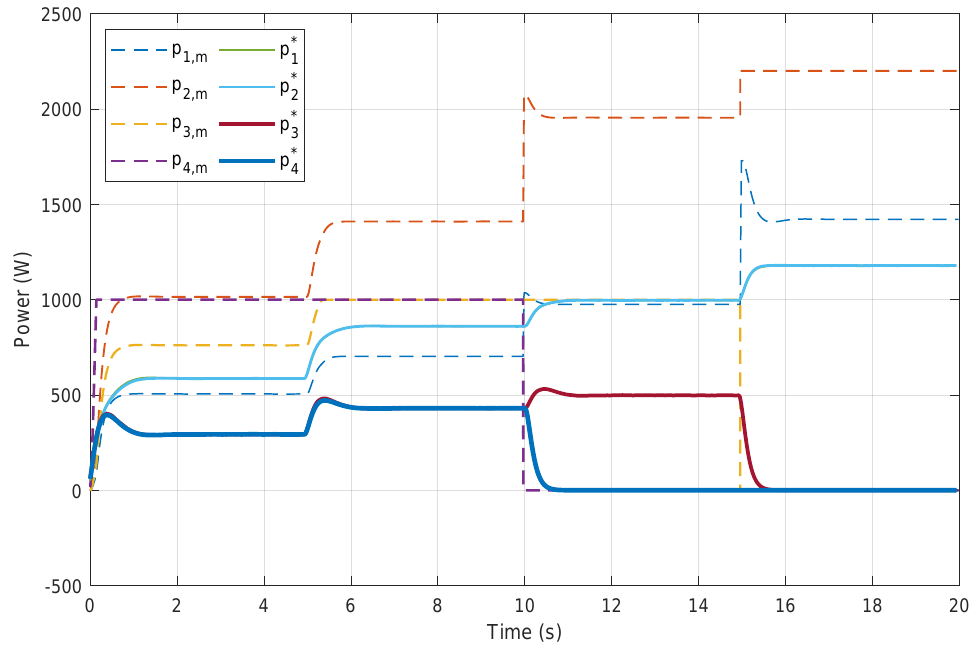
Figure 7. Conventional droop control strategy performance: Active power sharing. The conventional droop control strategy can achieve proportional power sharing without any minimum/maximum capacity restriction violation. However, the injected power steady-state values ( p 1, m ,..., p 4, m ) do not track the optimal power references ( p ∗ ,..., p ∗ ) that lead to a real-time optimal economic operation. 1 4 The optimal references have been computed in real-time using the Equations (9)–(11).